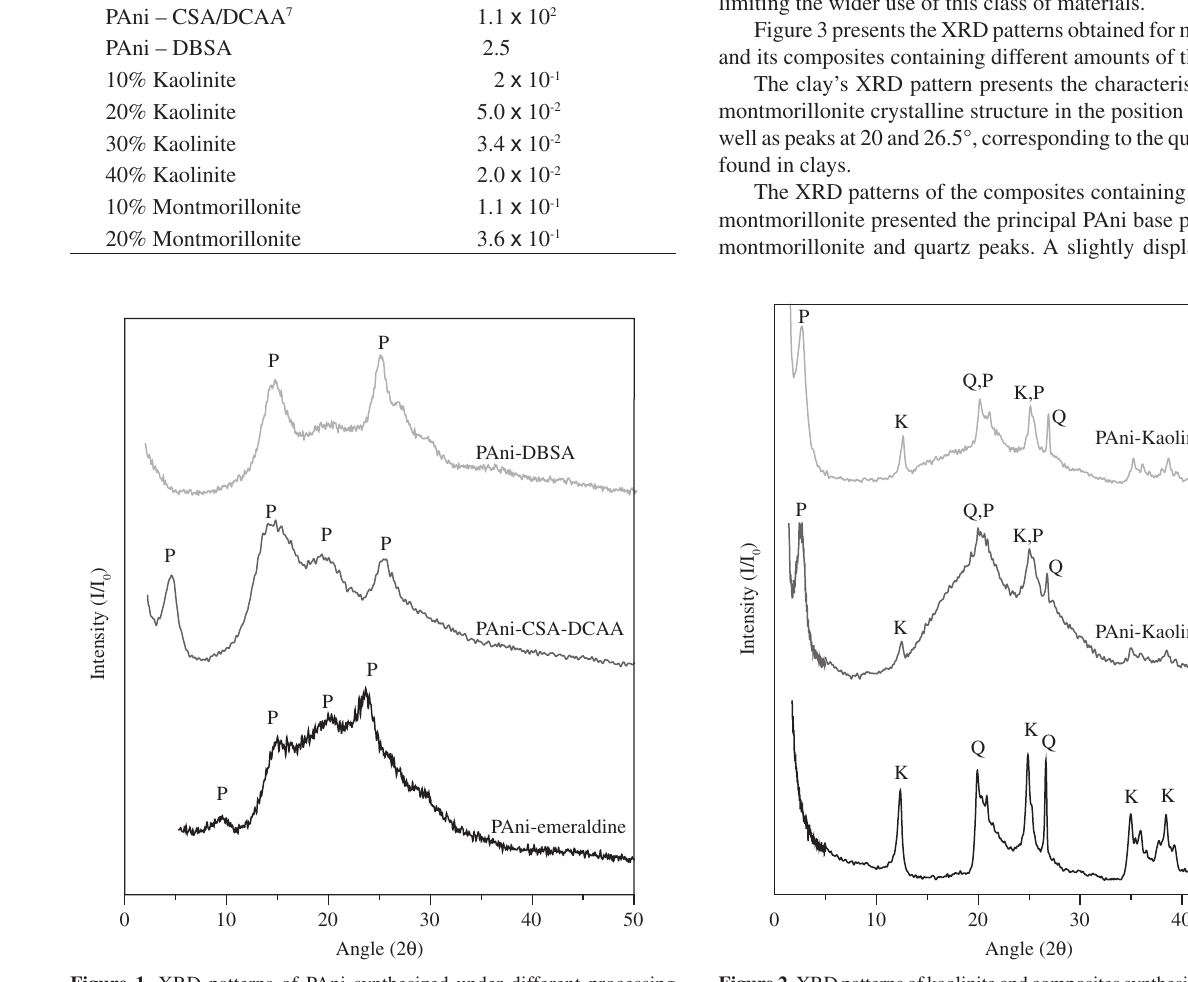
Figure 2. XRD patterns of kaolinite and composites synthesized with different amounts of mineral